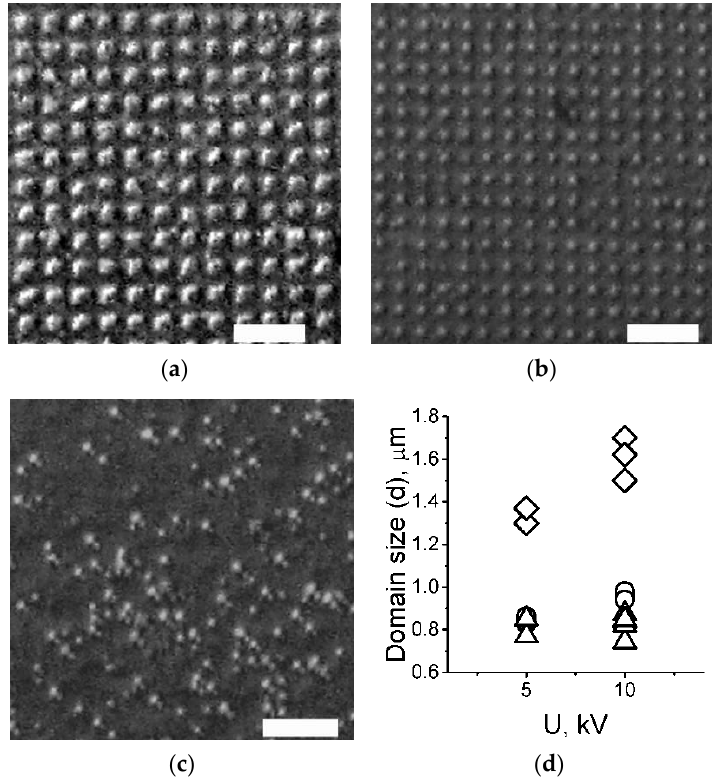
Figure 3. Optical images of domain structures written by Scheme A at U = 5 kV and D = 5000 µC/cm 2 using squares with side H equal to: ( a ) 1 µm, ( b ) 0.5 µm, ( c ) 0.25 µm. Scale bar corresponds to 5 µm. ( d ) Variation of the average lateral domain size ( d ) when varying U and H . Rhombuses— H = 1 µm, circles— H = 0.5 µm, triangles— H = 0.25 µm.